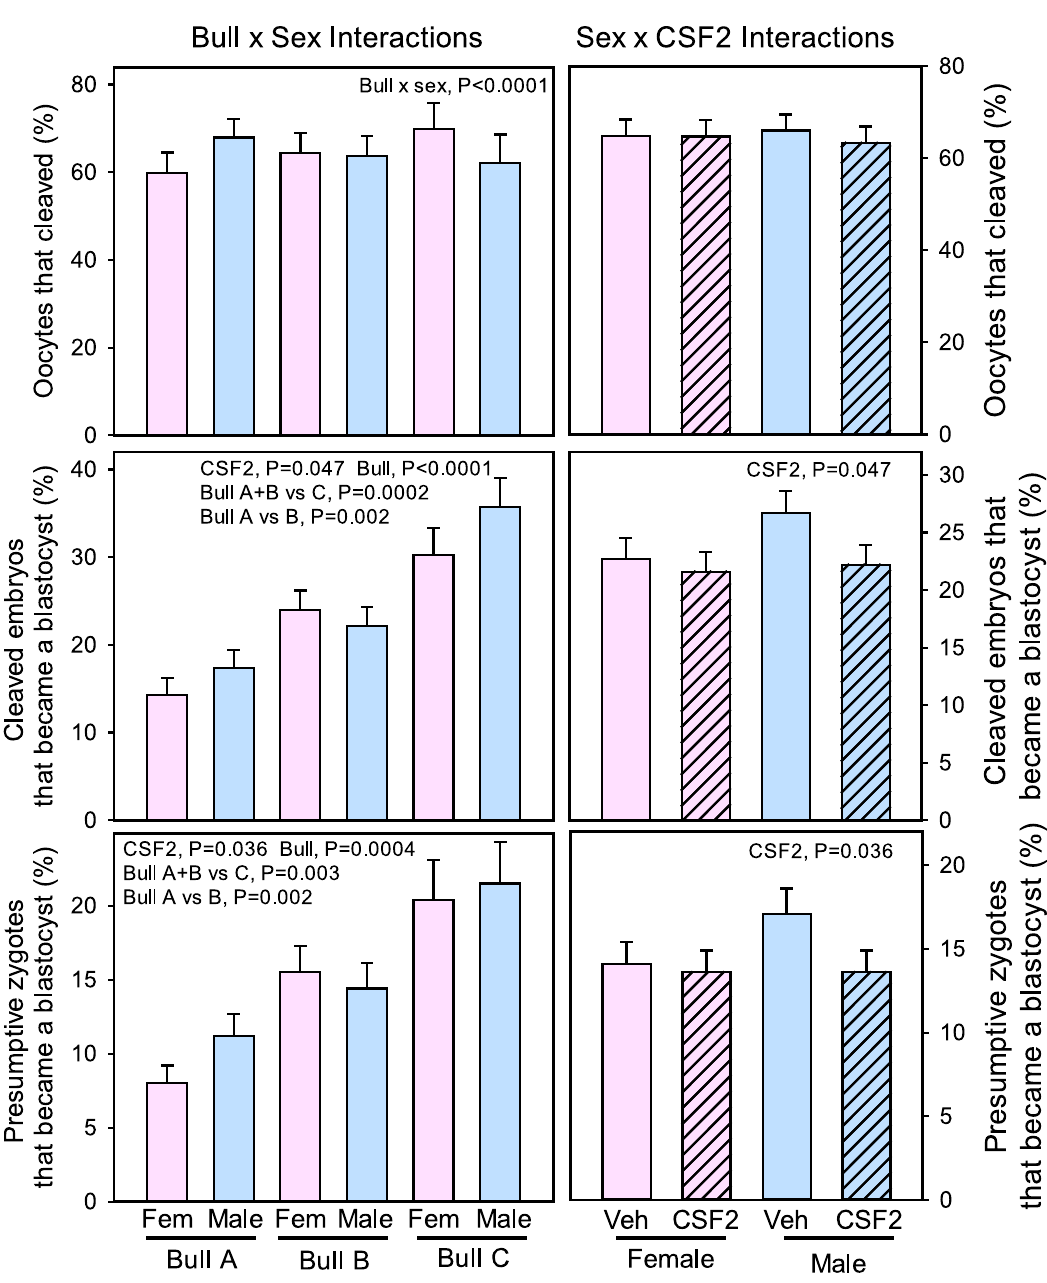
Fig 1. Competence of oocytes to cleave after fertilization and of embryos to develop to the blastocyst stage as affected by sex, bull and CSF2.